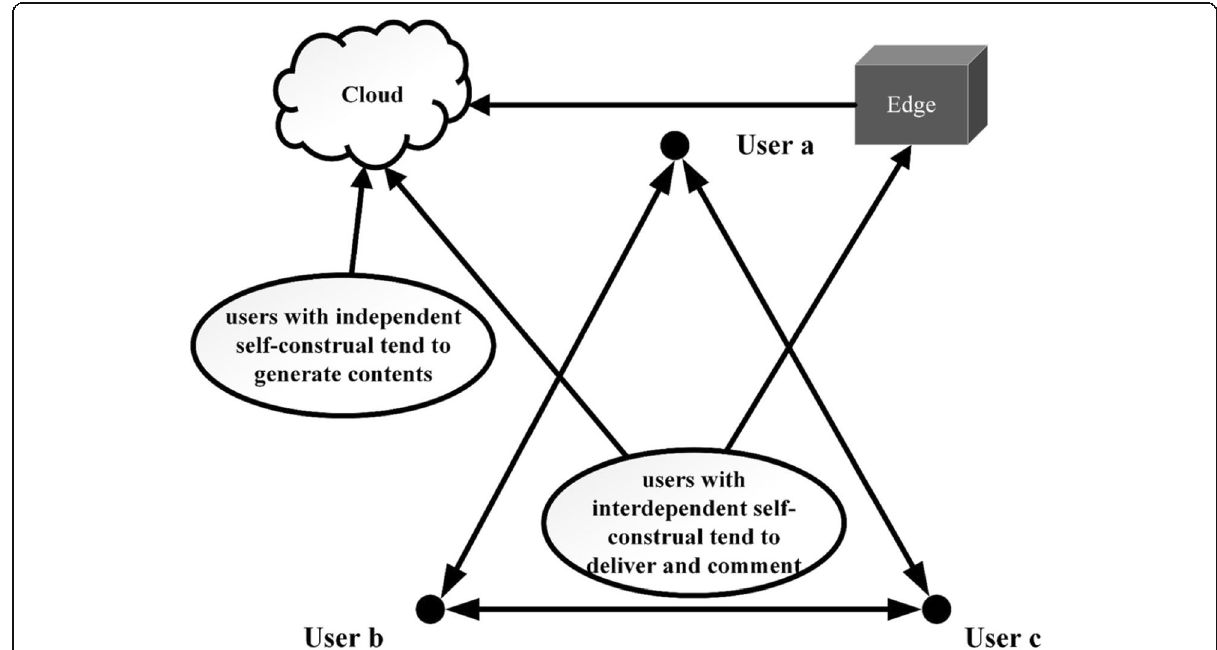
Fig. 1 Attributes and behavioral characteristics of SC in